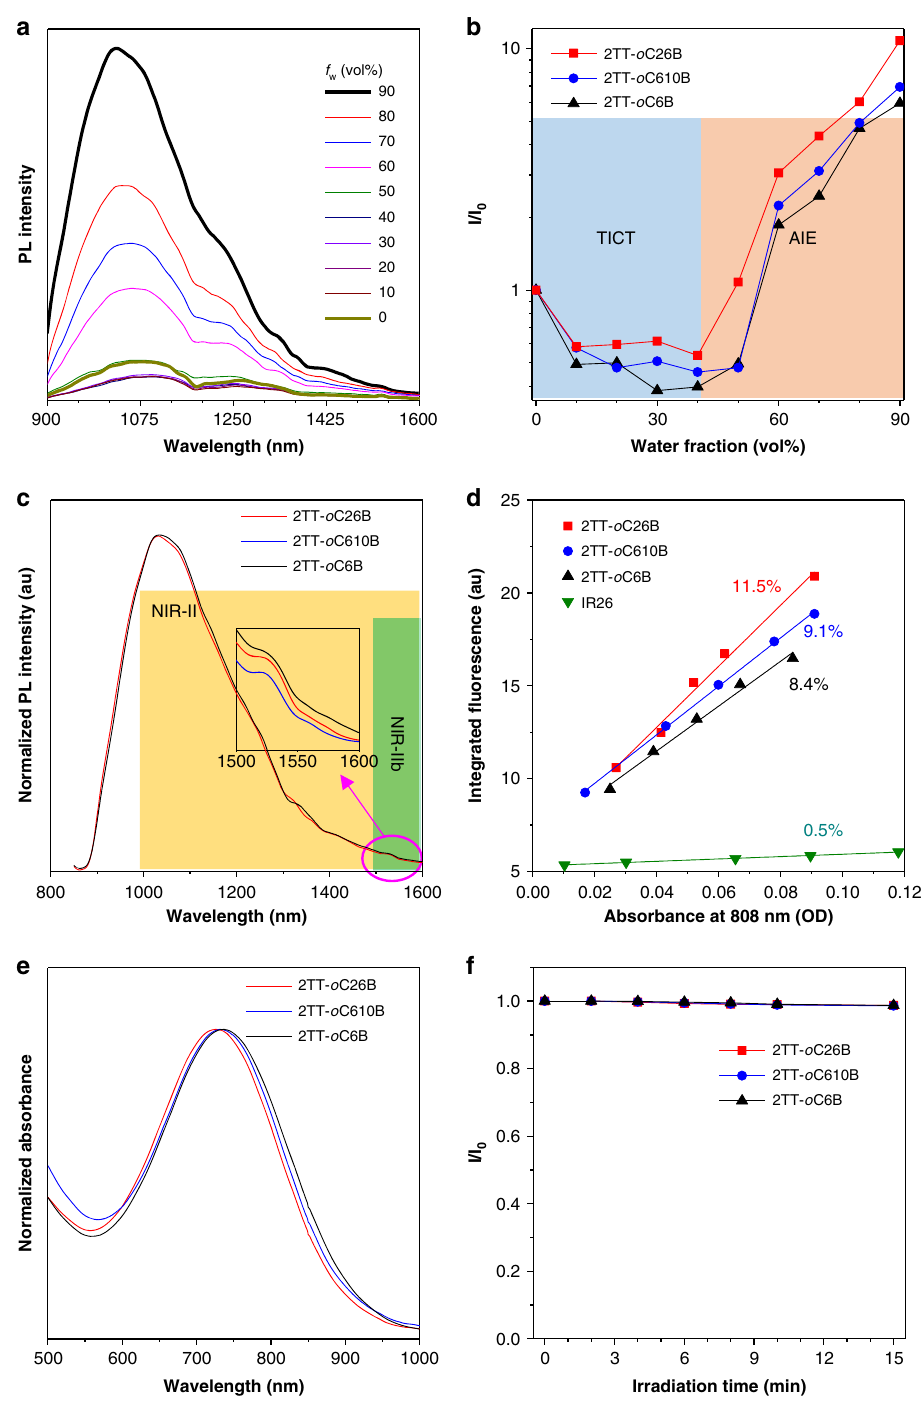
Fig. 3 Photophysical properties of the compounds. a PL spectra of 2TT- o C26B in THF/water mixtures with different water fractions ( f w ). b Variation in PL intensity ( I / I 0 ) of the three molecules with f w , where I and I 0 were the maximal PL intensity. c PL spectra of the nanoparticles. Inset: zoom-in emission spectra in the range of 1500 – 1600 nm. d The plots for the integrated fl uorescence spectra of the three compounds nanoparticles (1000 – 1600 nm) and IR- 26 (1050 – 1500 nm, QY = 0.5% in dichloroethane) at fi ve different concentrations. e Absorption spectra of the nanoparticles. f The plot of absorption intensity ( A / A 0 ) under continuous irradiation (110 mW/cm 2 ), where A and A 0 were the maximal absorption intensity before and after laser irradiation, respectively. Source data are provided as a Source Data fi Supplementary Table 1) 49 ; while the QY in the NIR-IIb region THF was much lower than that of aggregate (nanoparticle) state (1500 – 1600 nm) was calculated to be 0.12%, 0.11% and 0.09%, due to the non-radiative decay by strong molecular motions respectively. The NIR-IIb QY of 2TT- o C26B NPs is signi fi cantly (Supplementary Fig. 18 and Supplementary Table 1). Notably, the higher than the reported SWCNTs (QY = ~0.01%) 17 . The NIR-II absorption maxima of these AIE NPs located at 730 nm, which is fl uorescence QY of 2TT- o C26B, 2TT- o C610B, and 2TT- o C6B in useful for deep tissue excitation and avoiding photodamage to the